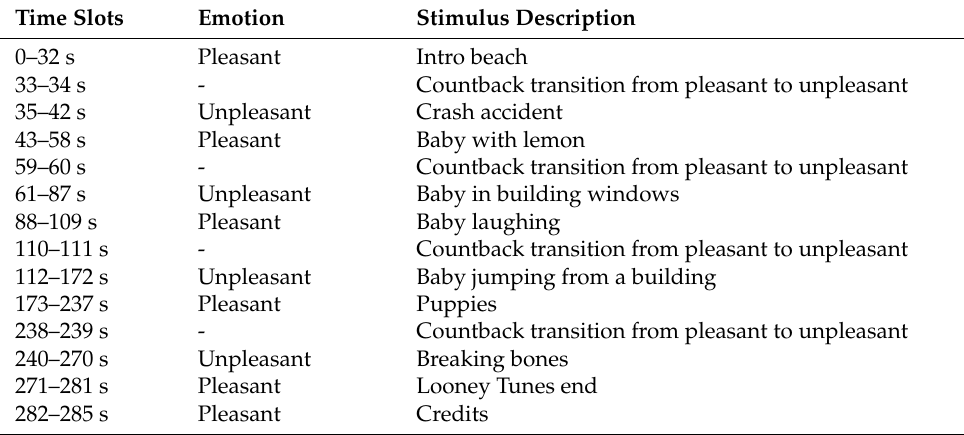
Table 3. Descriptions of the pleasant and unpleasant stimuli video